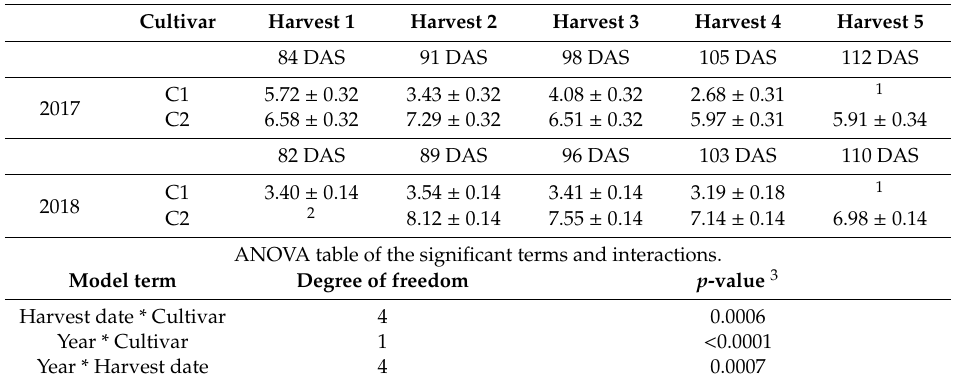
Table 7. Carthamidin content of flowering florets (%) for the two years (2017 and 2018) and the two cultivars (German and Chinese cultivar (C1 and C2)) of the five harvests (Harvest 1–5) (DAS, days after sowing) represented as mean values ± standard